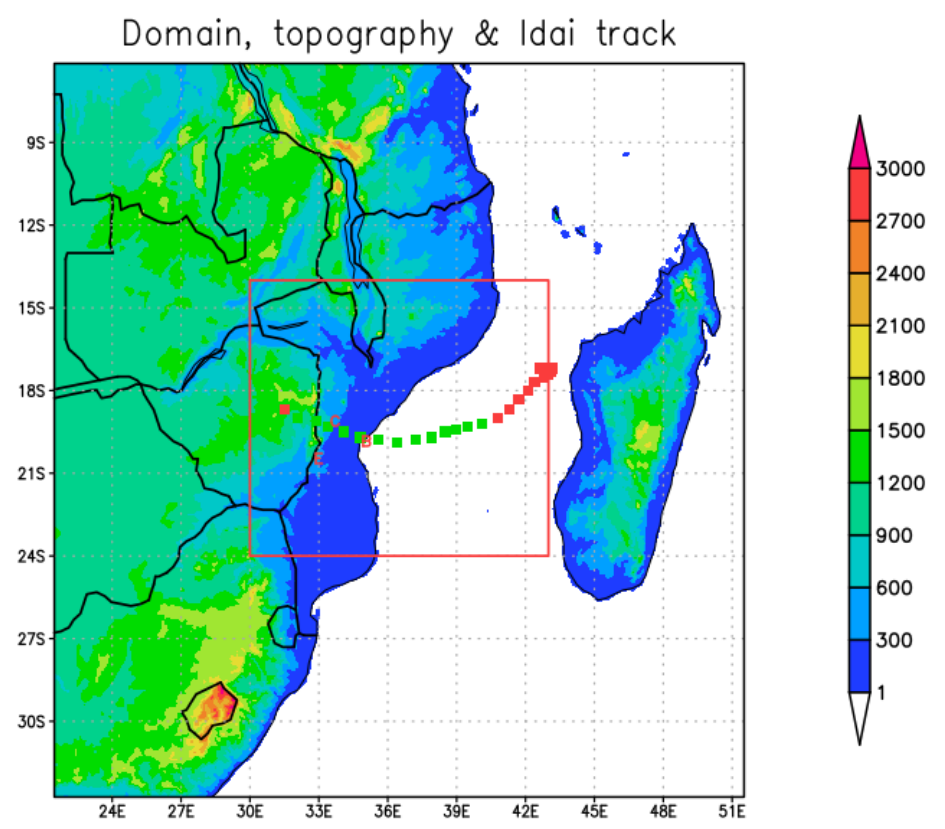
Figure 1. The simulation domain, with the shaded colours indicating topography in m. The red and green squares show the path of the cyclone based on Joint Typhoon Warning Center (JTWC) best track data, with green colours representing the simulation period considered in the current study. The three letters written in red are the first letters of the three stations, namely Beira, Chimoio and Espungaber, which are plotted at the location of the station. The red rectangle shows the area used for calculations that require area